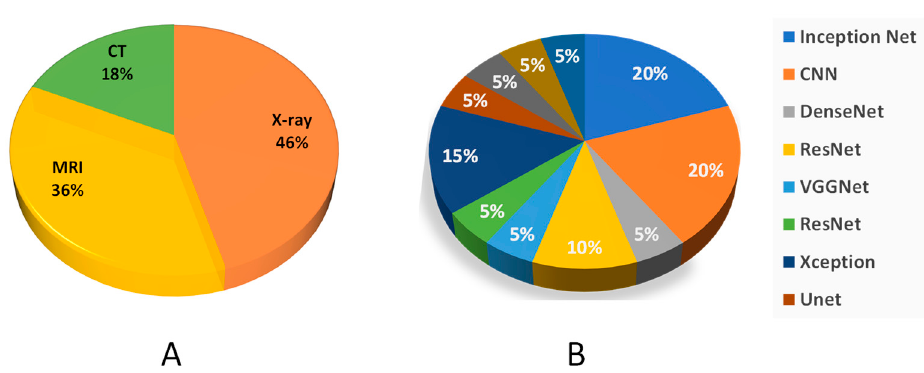
Figure 6. ( A ) Represents the usage of different modalities in deep learning. ( B ) Usage of deep learning models for fracture detection.